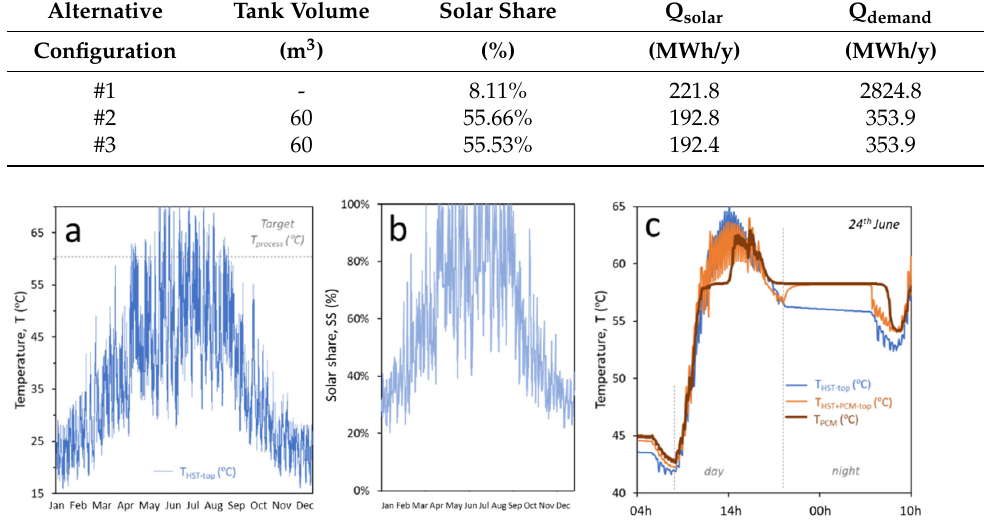
Figure 15. ( a ) Transient evolution of the HST top-side temperature in the second alternative solar integration configuration proposed for the French demo, using an HST without latent heat storage; ( b ) transient evolution of the solar share for the said configuration; ( c ) evolution of HST top-side temperature using HST without (blue) and with latent heat storage (orange), as well as transient PCM cartridge temperature along a specific calendar day, namely 24th June.